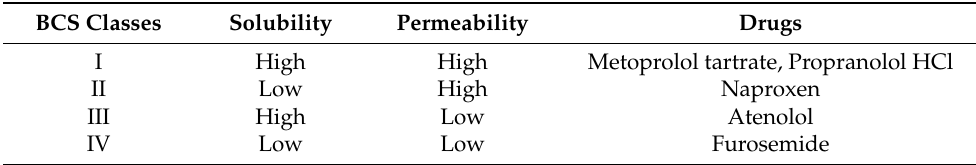
Table 1. Classification of the studied drugs according to the